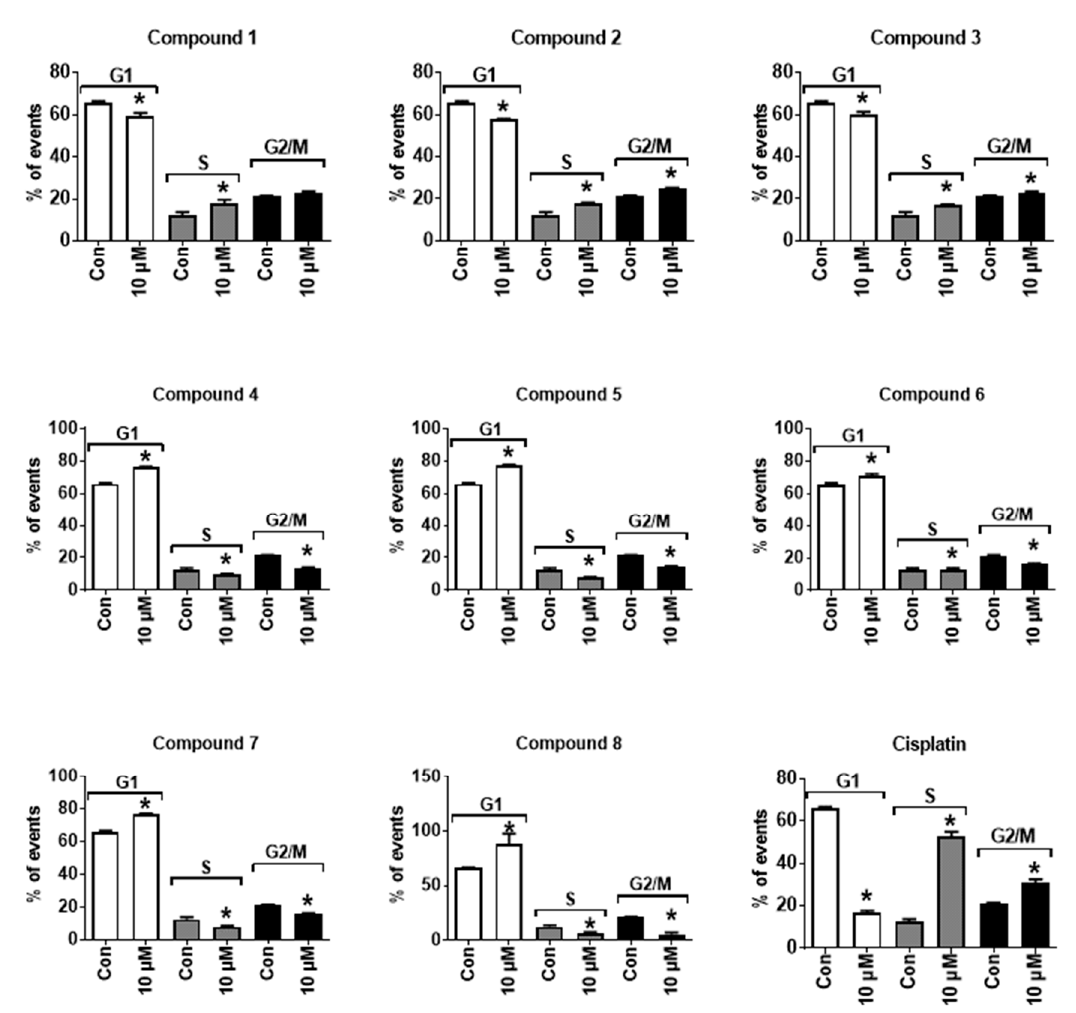
Figure 4. Treatment effects on the progression of the cell cycle of PC-3 cells. Cells were treated with the investigated compounds for 24 h. The effects were analyzed by flow cytometry. Cisplatin was used as a positive control. * p ≤ 0.05 (Student’s t-test).